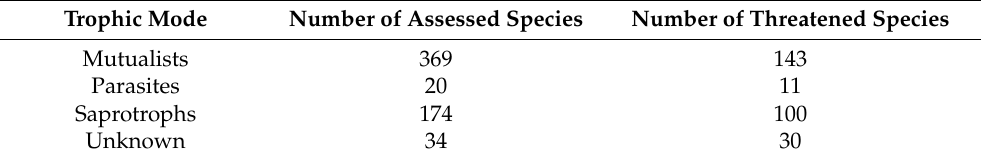
Table 1. Number of assessed and threatened species from each trophic mode.